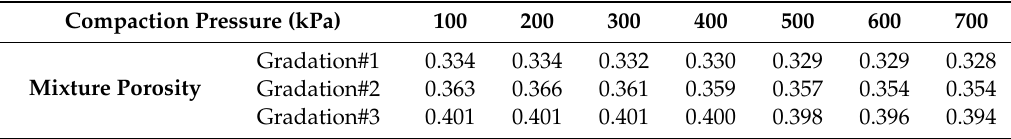
Table 4. The mixture porosity of di ff erent compaction pressures.